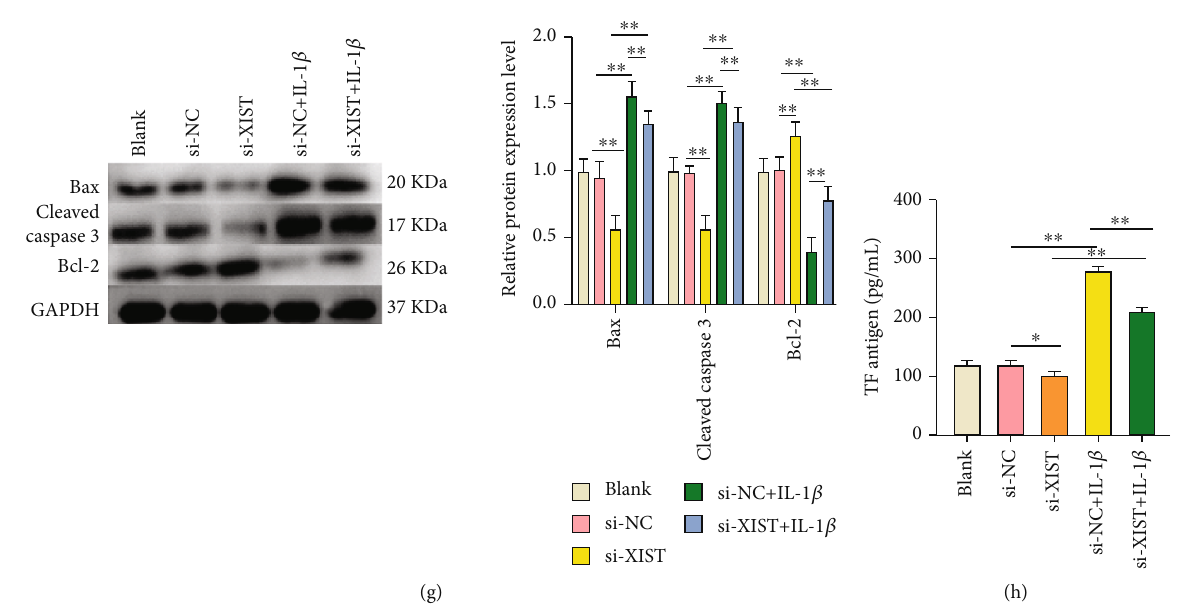
Figure 1: Knockdown of lncRNA XIST attenuated the apoptosis of HUVECs and resulted in a decrease of IL-1 β -induced TF level in vivo . (a) The expression levels of lncRNA XIST and miR-103a-3p were detected by qRT-PCR, and the expression level of HMGB1 was analyzed by qRT-PCR and western blot. (b) The correlations among the expression levels of lncRNA XIST, miR-103a-3p, and HMGB1 were calculated by Spearman ’ s rank-order correlation test. (c) The cell viability of HUVECs under IL-1 β addition was determined by MTT assay. (d) The expression levels of lncRNA XIST, miR-103a-3p, and HMGB1 were measured under IL-1 β treatment by qRT-PCR. (e) The expression level of lncRNA XIST in transfected HUVECs was analyzed by qRT-PCR, and the cell viability in transfected cells was detected by MTT assay. (f) The cell apoptosis was analyzed by Annexin V-FITC/PI double staining kit. (g) The expression levels of proteins related to apoptosis were detected by western blot. (h) The concentration of TF antigen was determined by the ELISA kit. The nontransfected HUVECs served as the blank group. ∗ P < 0 : 05 and ∗∗ P < 0 : 01 .